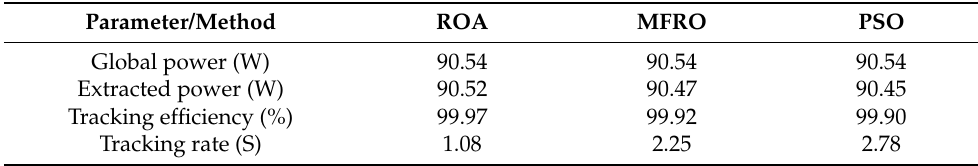
Table 5. Numerical results of ROA, MRFO, and PSO methods in pattern 2.